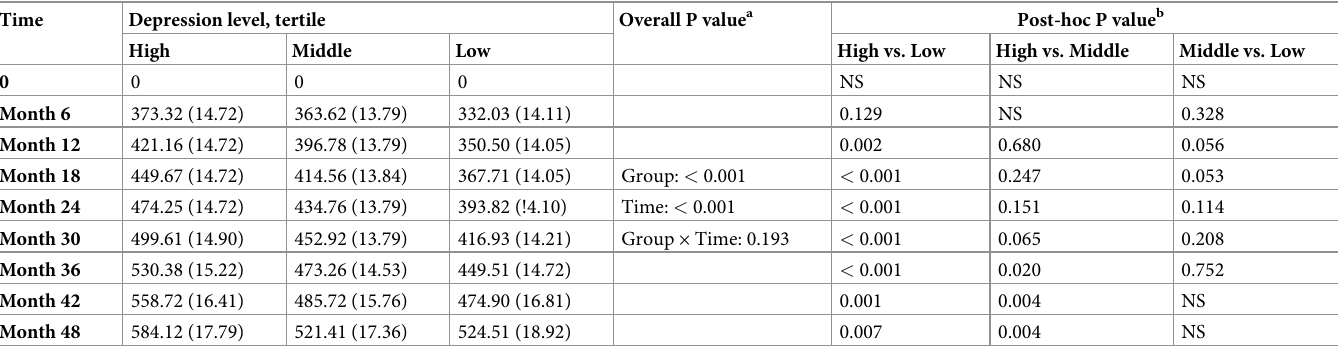
NS, not significant.